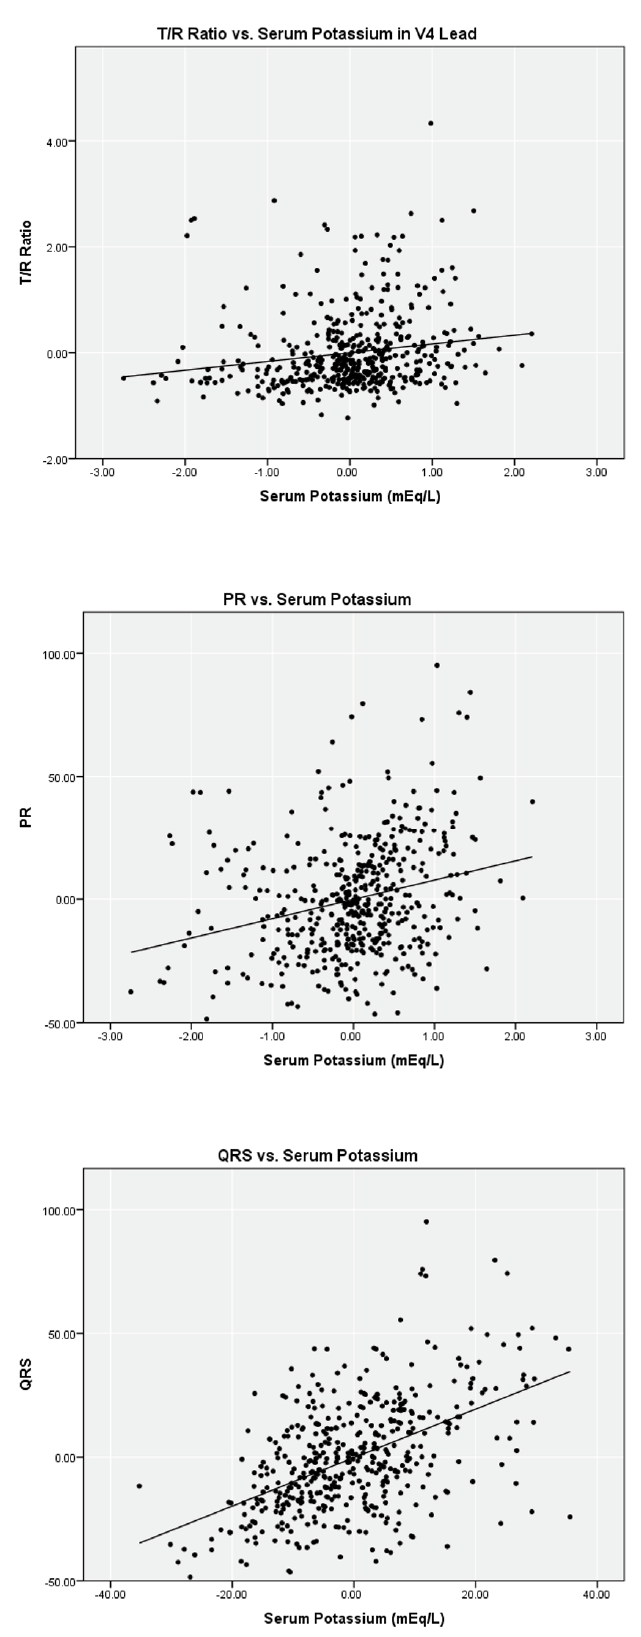
Figure 2. Partial linear correlation of serum potassium versus ECG parameters while controlling for ionized calcium and bicarbonate on complete data set ( n =